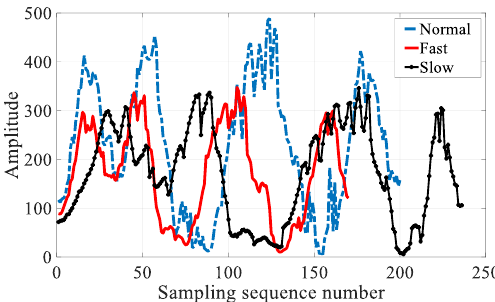
Figure 10. Different walking speed and sampling rate along a same path.